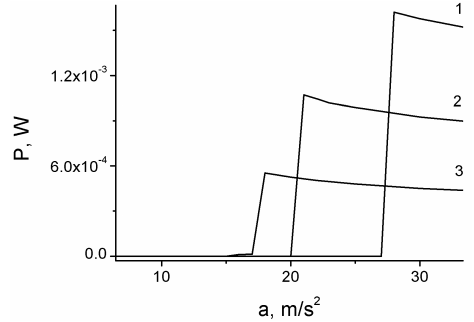
Figure 6. Output power of the generator as a function of external acceleration amplitude. k = 2 × 10 5 N/m, k 0 = 2 × 10 3 N/m, f = 200 Hz, R = 3 × 10 5 Ω , d 1 = d 0 = 17 μm, S = 1 cm 2 . V P = 293 V ( 1 ), 225 V ( 2 ), 158 V ( 3 ).